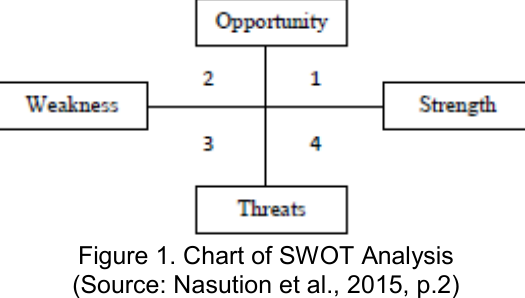
Figure 1. Chart of SWOT Analysis (Source: Nasution et al., 2015, p.2)